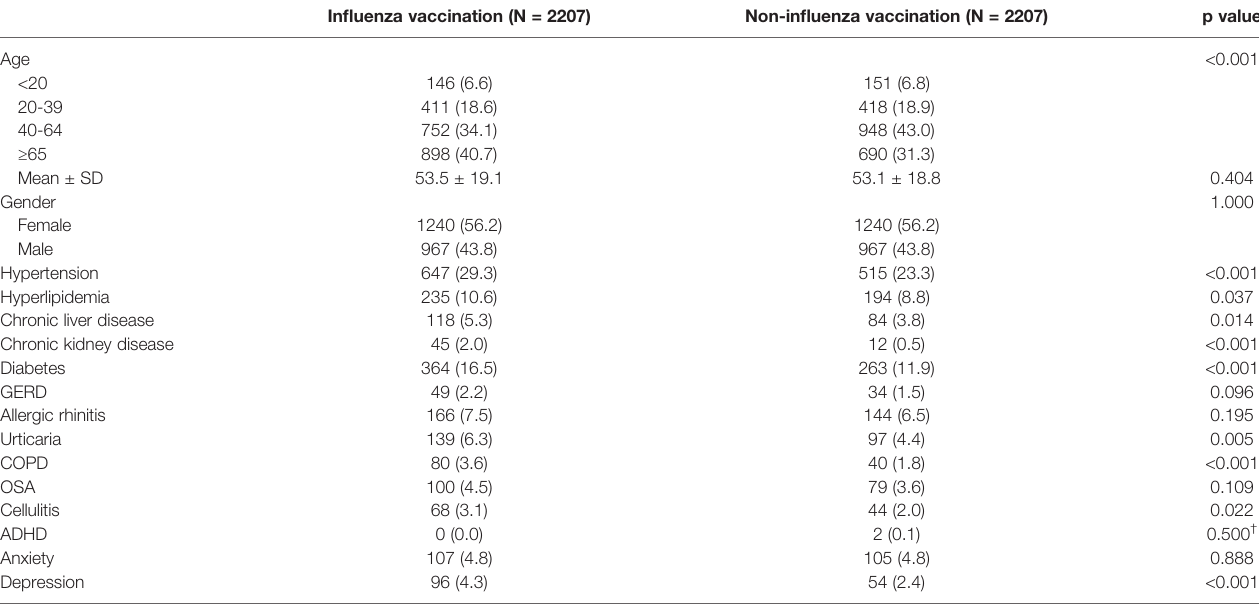
TABLE 1 | Demographic characteristics of in fl uenza vaccination group and non-in fl uenza